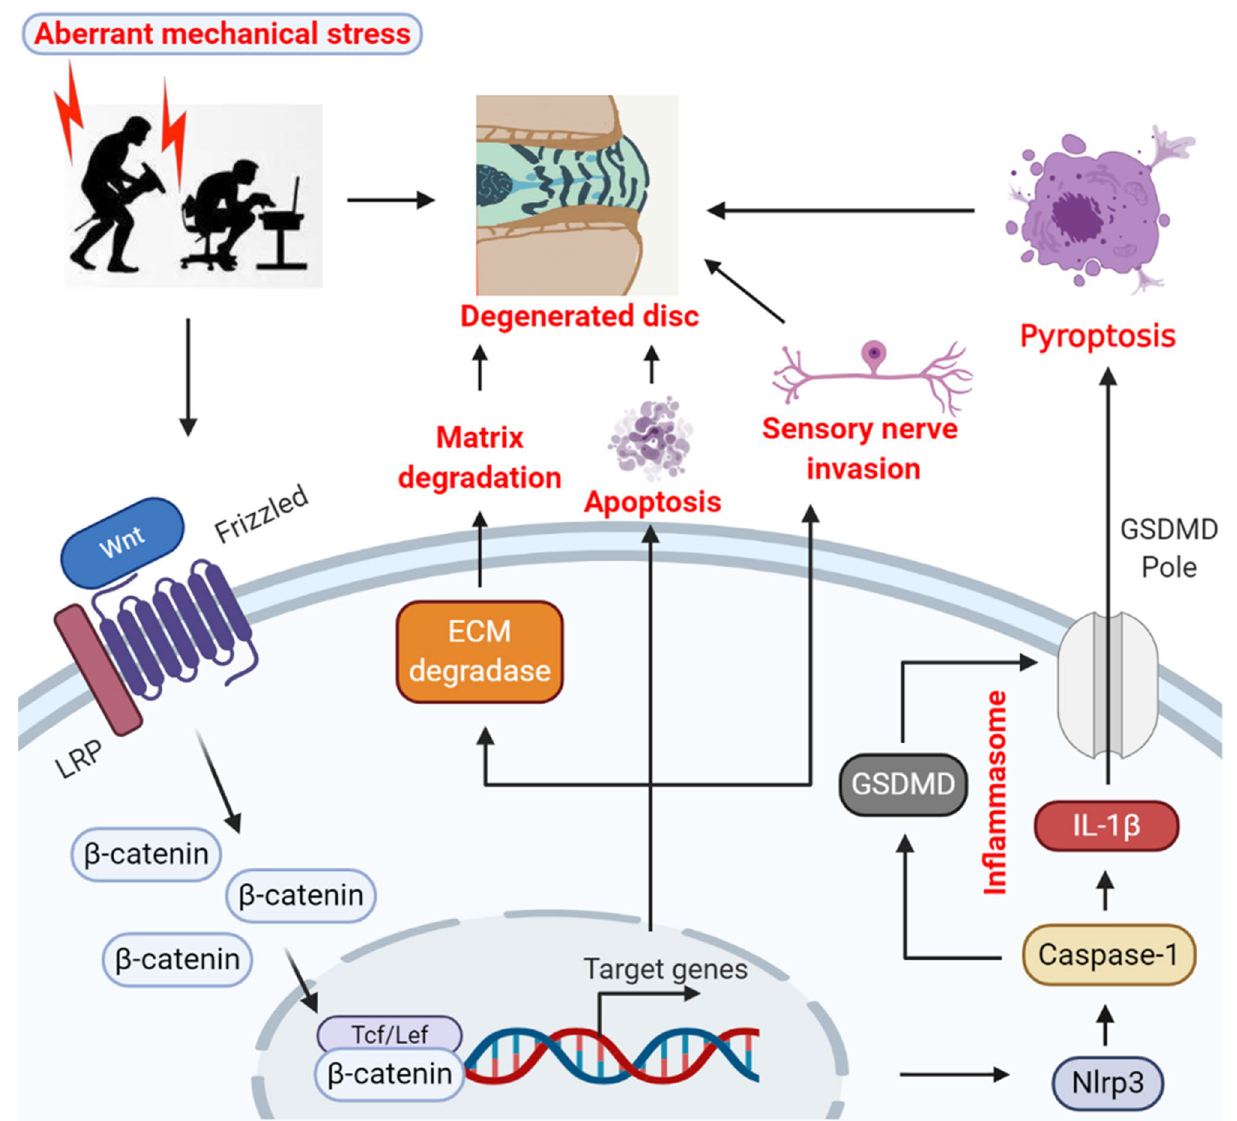
Figure 7. Working model for aberrant mechanical stress-induced IVDD progression by inducing pyroptosis and nerve ingrowth. The image was created by using the biorender software (https ://biore